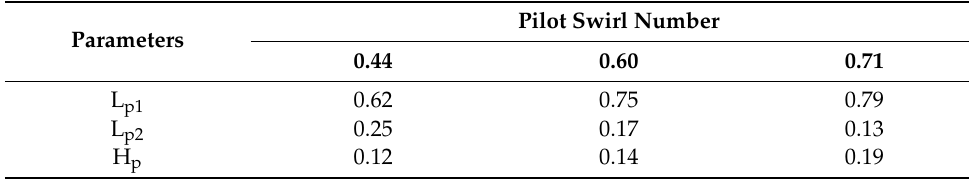
Table 3. Parameters of the three different